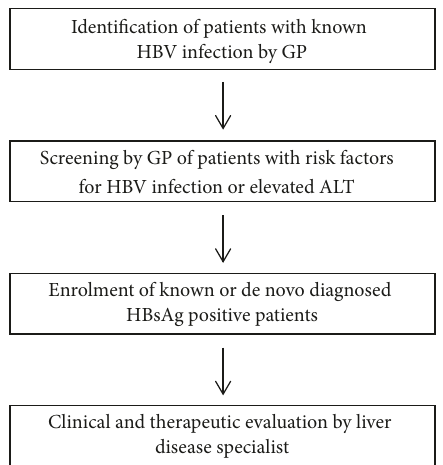
Figure 1: Flowchart of the fundamental phases of the program.